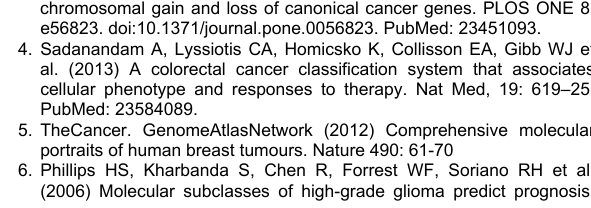
Figure S1. Scatter plot of correlation coefficient. A linear model was fit to the data using correlation coefficients by transcriptional profile as the independent variable. The resulting p-value and coefficient were showed. Figure S2. Comparison of ovarian cancer and other cancer. Tumor samples were grouped by subtype. Yellow grids represented positive correlation while blue grids represented negative correlation. The number of samples per subtype was inside the brackets.